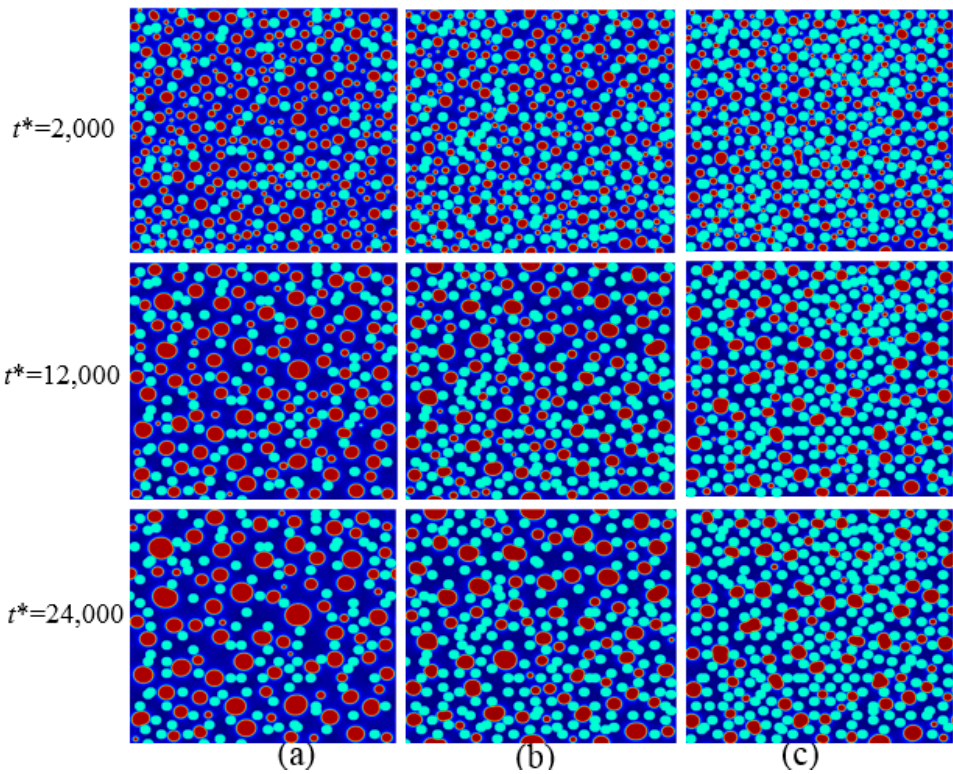
Figure 5. Simulation snapshots of the system at different times are shown in vertical columns. Particle size, r *, is fixed to 20. Volume fractions of nanoparticles are: ( a ) 10%, ( b ) 20%, and ( c ) 30%. The nanoparticles are shown in light blue, precipitates are colored red, and the matrix is in dark blue.